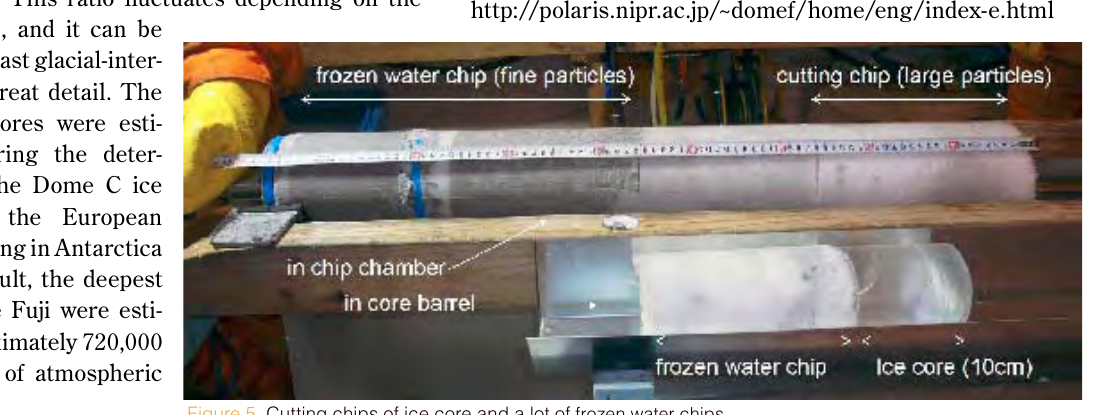
Figure 5. Cutting chips of ice core and a lot of frozen water chips.